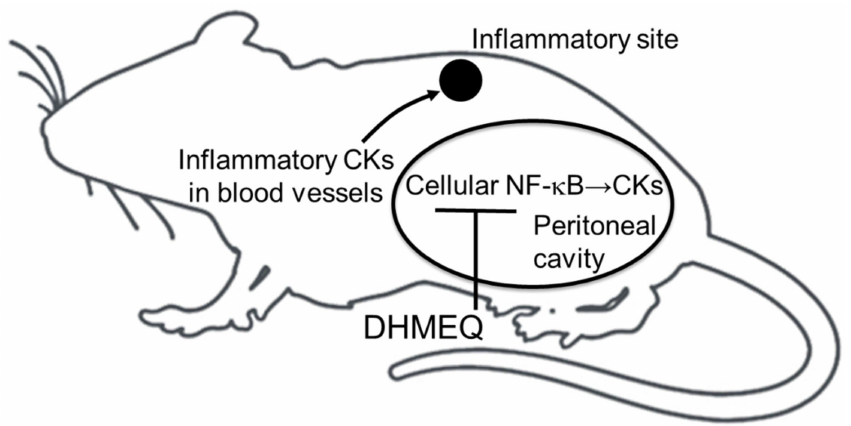
Figure 6. Possible mechanism for anti-inflammatory activity of DHMEQ by IP administration. DHMEQ acts only in the peritoneal cavity. CK,